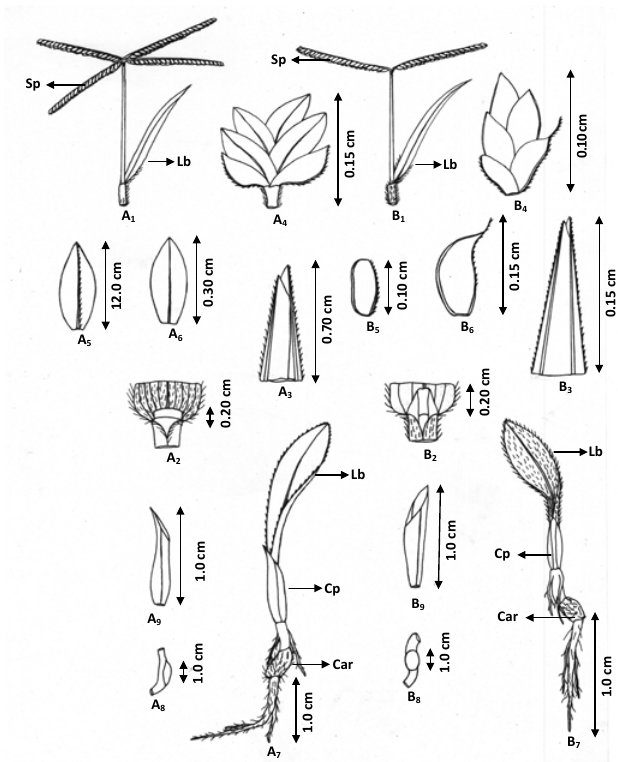
Fig. 1. (Original) A : Dactyloctenium aegyptium : A 1 -Plant twig, A 2 -Ligule, A 3 -Prophyllum, A 4 -Spikelet, A 5 -Lower glume, A 6 - Upper glume, A 7 -Seedling, A 8 -Scutelum, A 9 -Coleoptile. B : Dactyloctenium aristatum : B 1 -Plant twig, B 2 -Ligule, B 3 -Prophyllum, B 4 -Spikelet, B 5 -Lower glume, B 6 -Upper glume, B 7 -Seedling, B 8 -Scutelum, B 9 -Coleoptile, Cp-Coleoptile, Car-Caryopsis, Lb-Leaf blade, Sp-Spikelet